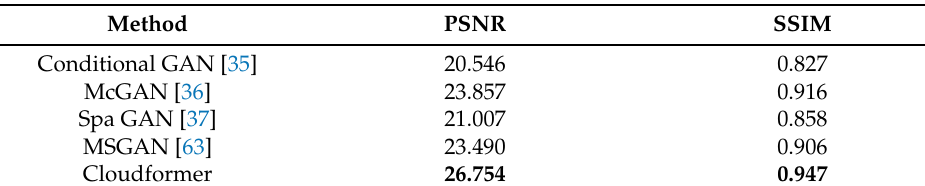
Table 6. Quantitative evaluation on Paris dataset.